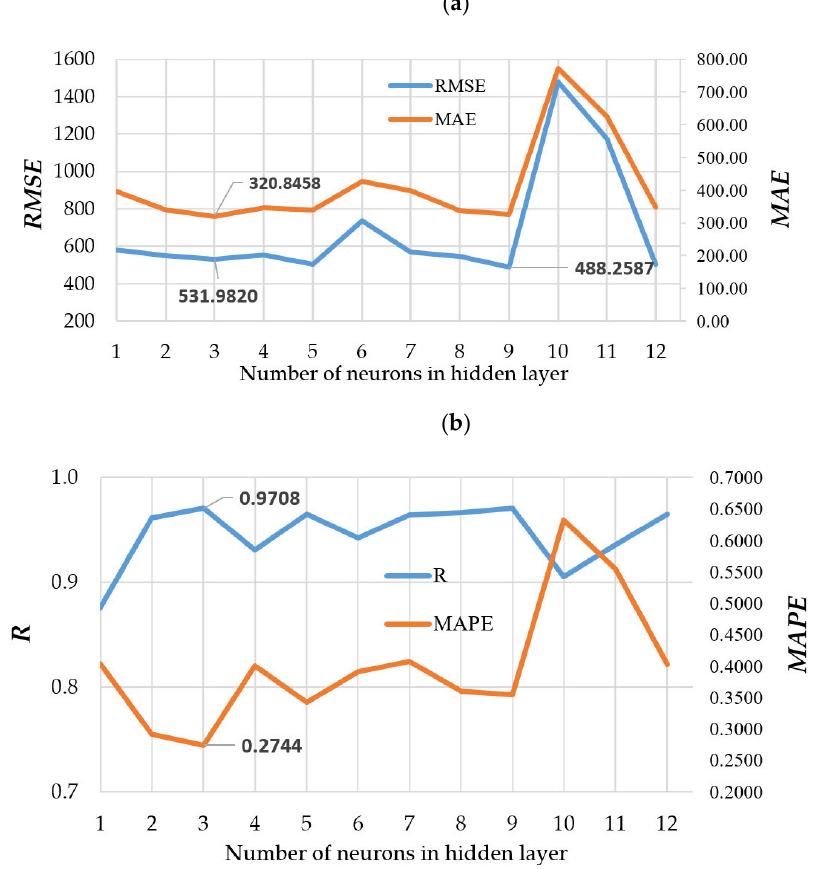
Figure 9. Accuracy examination of MLP neural network models in accordance with established ac ‐ curacy criteria: ( a ) RMSE and MAE; and ( b ) R and MAPE.. accuracy criteria: ( a ) RMSE and MAE; and ( b ) R and